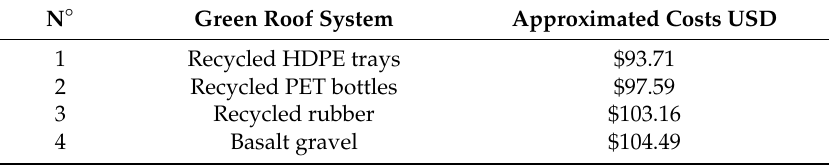
Figure A1. Data employed to estimate typical and intense rainfall conditions. ( a ) Typical rainfall conditions (from 23 to 29 October 1987). ( b ) Intensity–frequency–duration (IFD) curve for intense rainfall (data from 2 June 1995). Table A1. Approximated costs for each roofing system proposed (Value for 1 m 2